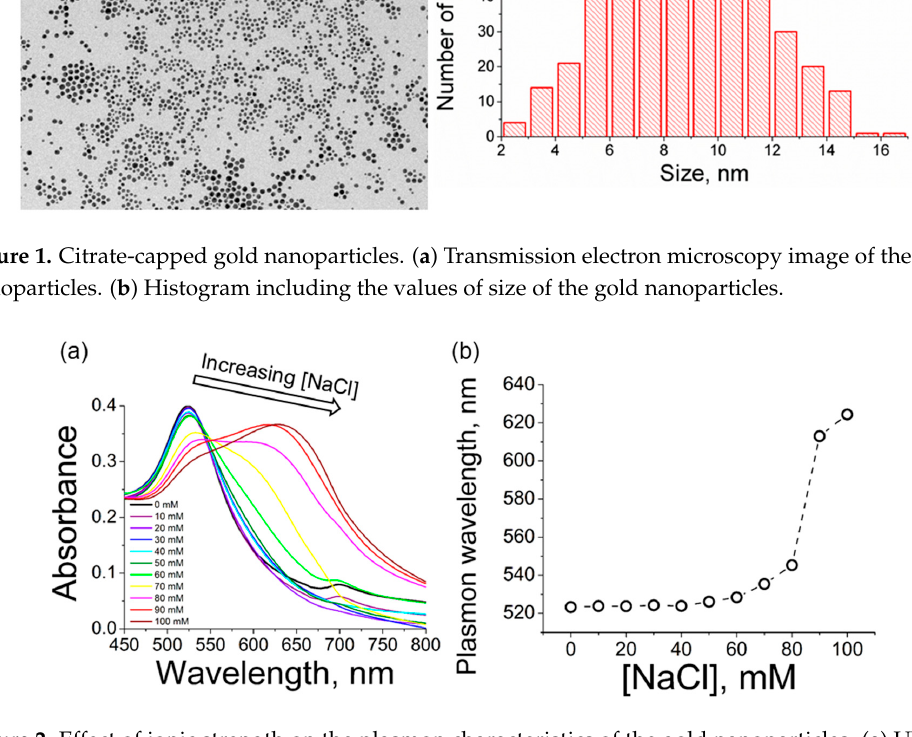
Figure 2. Effect of ionic strength on the plasmon characteristics of the gold nanoparticles. ( a ) UV-vis spectra of the dispersion of gold nanoparticles at different concentrations of sodium chloride from 0 mM (black line) to 100 mM (brown line). ( b ) Values of wavelength corresponding to the plasmon peaks of the gold nanoparticles against ionic strength. The line is included as a guide for the eye. During the synthesis of the nanoparticles, the citrate ions act both as reducing and capping